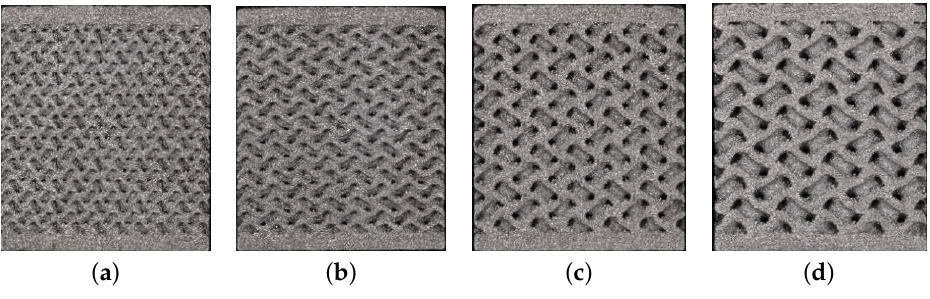
Figure 7. Basic cells of gyroid structures—Phase I: ( a ) G1-I, ( b ) G2-I, ( c ) G3-I, ( d ) G4-I. Table 2. Types and geometry of basic gyroid cell units—Phase I.